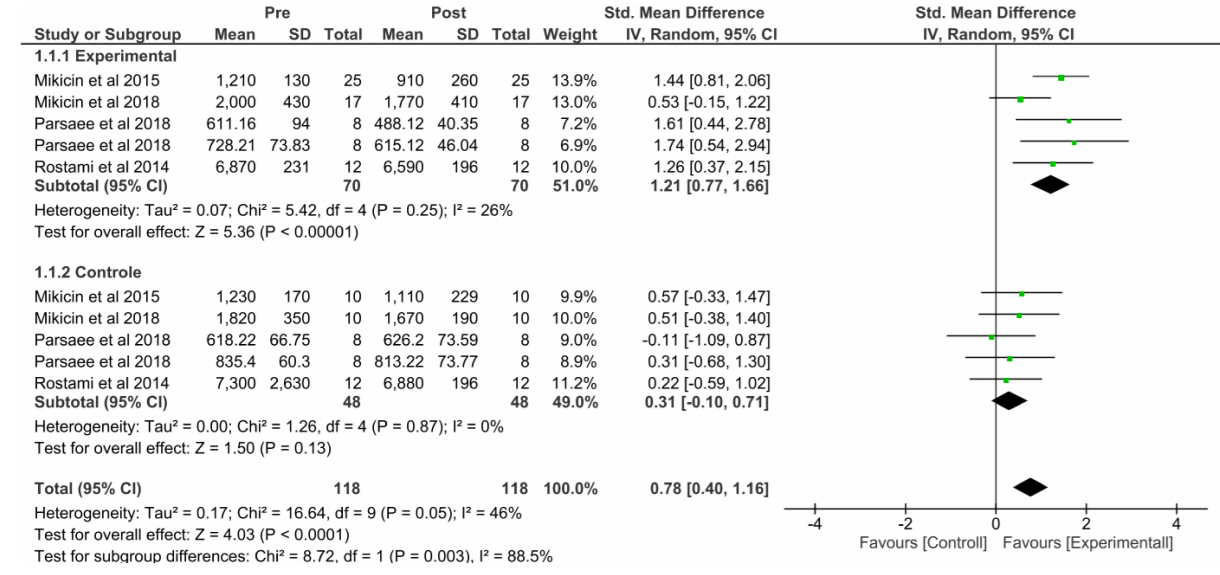
FIGURE 3 | Forest plot comparing the NFB group with the control group after sports performance indicating the improvement in the reaction time of the athletes. Created using Software Review Manager 5.4.1.